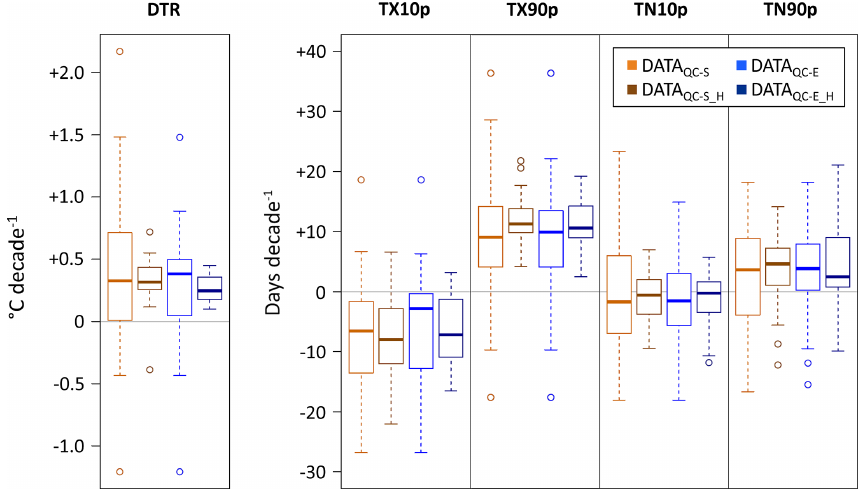
Figure 9. Trends of individual station records of the complete study area for the climate change indices daily temperature range (DTR), number of cool days (TX10p), number of warm days (TX90p), number of cool nights (TN10p), and number of warm nights (TN90p) in the period 1981 to 2010. Colours indicate the different datasets that are unhomogenized and quality controlled with the standard approach (DATA QC-S ), homogenized and quality controlled with the standard approach (DATA QC-S_H ), unhomogenized and quality controlled with the enhanced approach (DATA QC-E ), and homogenized and quality controlled with the enhanced approach (DATA QC-E_H ). For the DTR, trends are specified in ◦ C per decade and for the other indices in days per decade. The box plots show the median, the 25th and 75th percentile, and the 1 . 5 × IQR (whiskers).